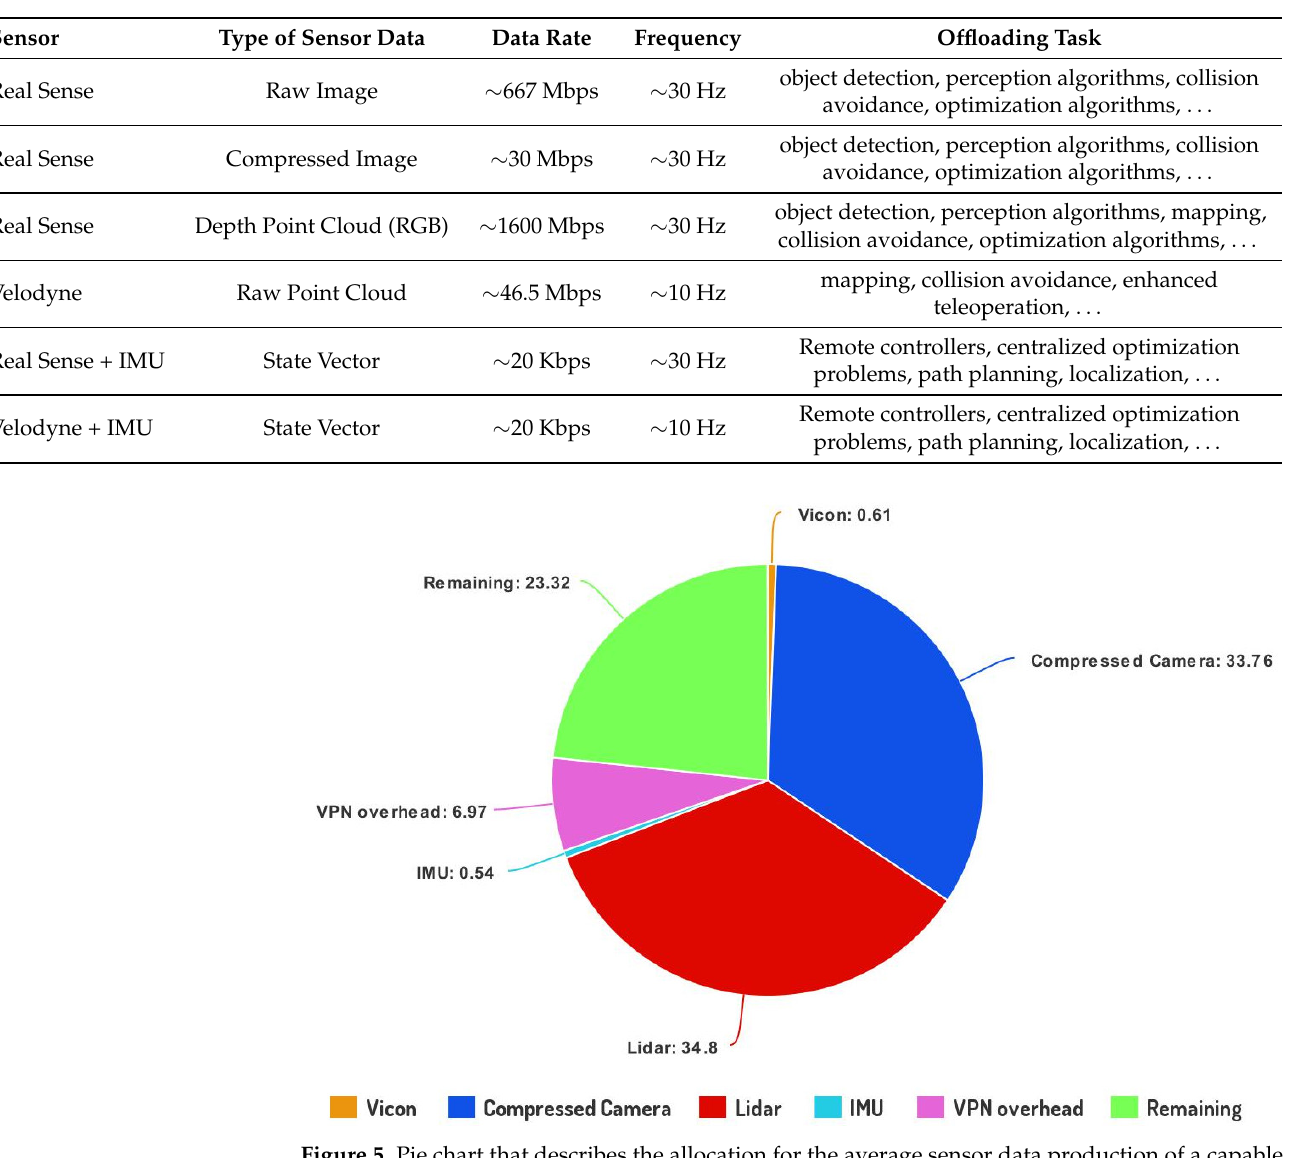
Table 2. This table shows the average data rates measured from the ROS bandwidth tool in the application layer for various types of sensor data topics. The rightmost column depicts the potential offloading task.